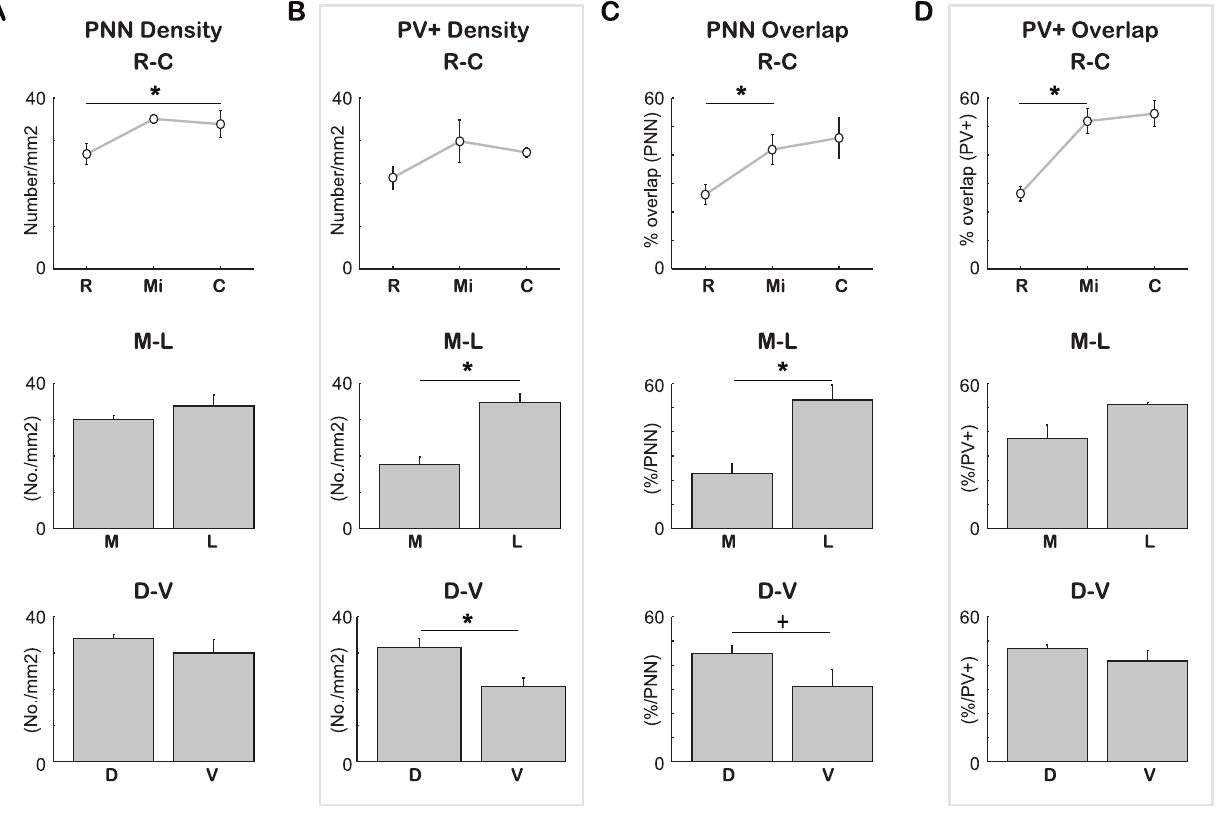
Figure 2. PNN/PV + cell density as well as overlap depend on topographic location within the striatum. (A) Rostral striatum exhibited a slightly decreased density of PNNs compared to the caudal most regions (pairwise comparisons, Bonferroni corrected; P =0.039, top panel). No differences were observed along either the mediolateral (middle panel) or dorsoventral axes (bottom panel). (B) In contrast, no difference was seen along the rostrocaudal axis in PV + density (top panel). Highly significant differences, however, were observed across both mediolateral (RMANOVA; P =0.002, middle panel), and dorsoventral axes (RMANOVA; P =0.016, bottom panel), reflective of distributions observed in other species. (C) A significant difference in the percentage of PNNs associated with PV + cells was observed in the rostral-caudal axis, with the rostral most section exhibiting significantly less overlap compared to the middle section (RMANOVA; within subject contrasts for sections, P =0.033., top panel). Significant differences were also observed in mediolateral axis, with medial striatum showing highly significantly less association between these two structures (RMANOVA; P =0.005, middle panel). Although overlap was less in ventral vs. dorsal regions, this difference did not reach significance (RMANOVA; P =0.068, bottom panel). (D) Similarly, rostral sections show a significantly smaller percentage of parvalbumin-positive cells surrounded by PNNs compared to more caudal areas of the striatum (RMANOVA; within subject contrasts for section, P =0.036, top panel). No differences were observed in the other axes (middle and bottom panels). R: rostral; Mi: middle; C: caudal; M: medial; L: lateral; D: dorsal; V: ventral. *: P , 0.02. + : P , 0.07.